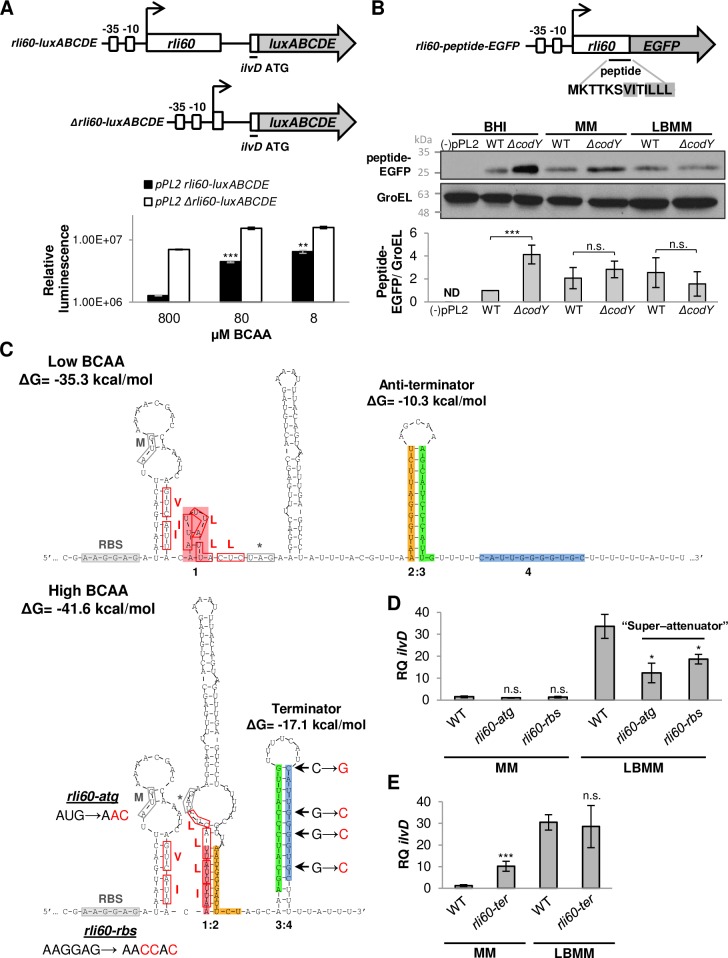
Rli60 functions as a ribosome-mediated transcriptional attenuator.(A) The regulatory region of ilvD (675 bp upstream to ilvD start codon) harboring rli60 or deleted of rli60 was fused to a luciferase reporter system (luxABCDE). Schematic representation of the two reporter systems are shown. On the lower panel; luminescence measurements of E. coli bacteria auxotrophic for BCAA (K-12 ilvC::Km), harboring pPL2-rli60-luxABCDE or pPL2-Δrli60-luxABCDE plasmid, grown in MM medium supplemented with 8, 80, or 800 μM of each BCAA. Results are presented as relative luminescence units normalized to the bacterial relative growth (OD600 values). The Y-axis is presented at logarithmic scale. The data is representative of 3 biological replicates (N = 3). Error bars represent standard error of a technical duplicate. Asterisks represent P-values (* = P<0.05, ** = P<0.01, *** = P<0.001, n.s. = non-significant), calculated using Student’s t-test. P-values represent a comparison to the 800 μM sample, unless indicated otherwise. (B) A translational fusion of rli60-leader peptide (13 aa) to enhanced green fluorescent protein (EGFP). A schematic representation of the reporter system is shown. A Western blot analysis of EGFP-leader peptide in WT and ΔcodY bacteria, harboring pPL2-rli60-peptide-EGFP, grown under the different media. (-)pPL2 denotes bacteria that were not conjugated with the plasmid as a negative control. Anti-GFP antibody was used for the detection of EGFP protein, and detection of GroEL was used as a loading control. A representative blot is presented. Densitometry analyses of 3 independent experiments are shown. Peptide-EGFP protein levels were normalized to GroEL protein and to the respective WT BHI sample (ND = not detected). The data represent 3 biological replicates (N = 3). Error bars indicate standard deviation. Asterisks represent P-values (*P<0.05, **P<0.01, ***P<0.001, n.s. = non-significant), calculated using Student’s t-test. (C) Identification of 2 alternative RNA structures in Rli60 using PASIFIC [32]. Four segments are represented in colors demonstrating the overlapping hairpins that are formed (segment 1-pink, 2-orange, 3-green and 4-blue). The first structure in the upper panel stabilizes an antiterminator hairpin (segments 2 and 3) exhibiting a ΔG of -10.3 kcal/mol. The second structure in the lower panel stabilizes a terminator haipin (segments 3 and 4) exhibiting a ΔG of -17.1 kcal/mol. The ribosome binding site (RBS), start codon, stop codon and the regulatory codons of the leader peptide are marked in gray and red boxes, in both structures. The stop codon is indicated by an asterisk. Point mutations are marked in red next to each feature. (D) RT-qPCR analysis of ilvD transcription level in WT, rli60-atg and rli60-rbs bacteria grown in MM and LBMM media. ilvD mRNA levels were normalized to rpoD mRNA levels and are represented as relative quantity (RQ), relative to the respective WT sample. The data represent 3 biological replicates (N = 3). (E) RT-qPCR analysis of ilvD transcription level in WT and rli60-ter bacteria grown in MM and LBMM media. ilvD mRNA levels were normalized to rpoD mRNA levels and are represented as relative quantity (RQ), relative to the respective WT sample. The data represent 3 biological replicates (N = 3). Error bars represent standard deviation. Asterisks represent P-values (* = P<0.05, ** = P<0.01, *** = P<0.001, n.s. = non-significant), calculated using Student’s t-test. P-values represent a comparison to the respective WT sample.